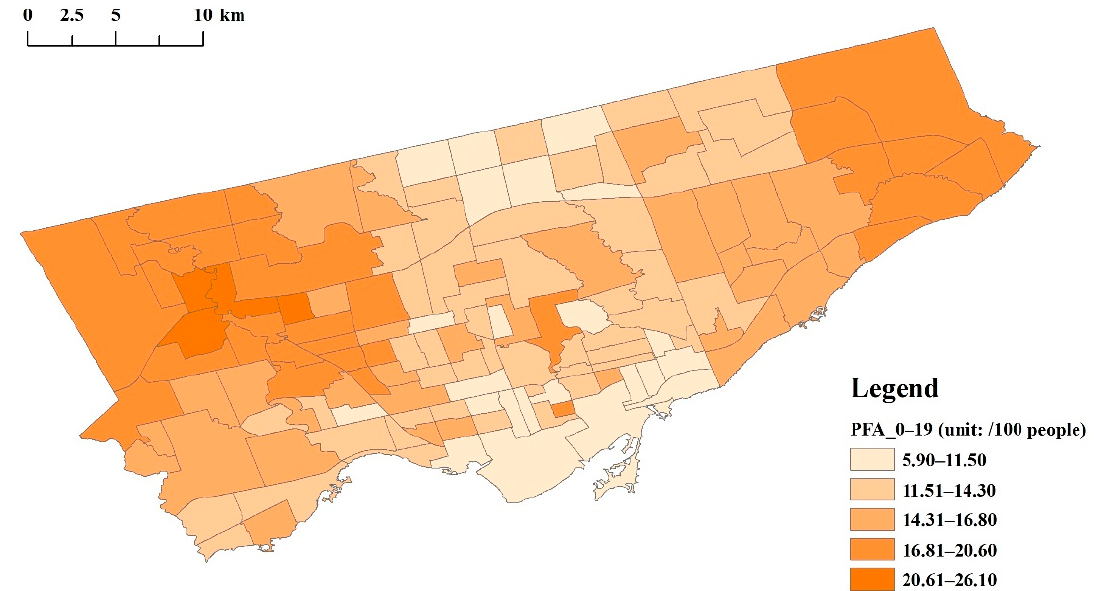
Figure A4. Distribution of the prevalence of female asthmatics aged 0–19 years (PFA_0–19).